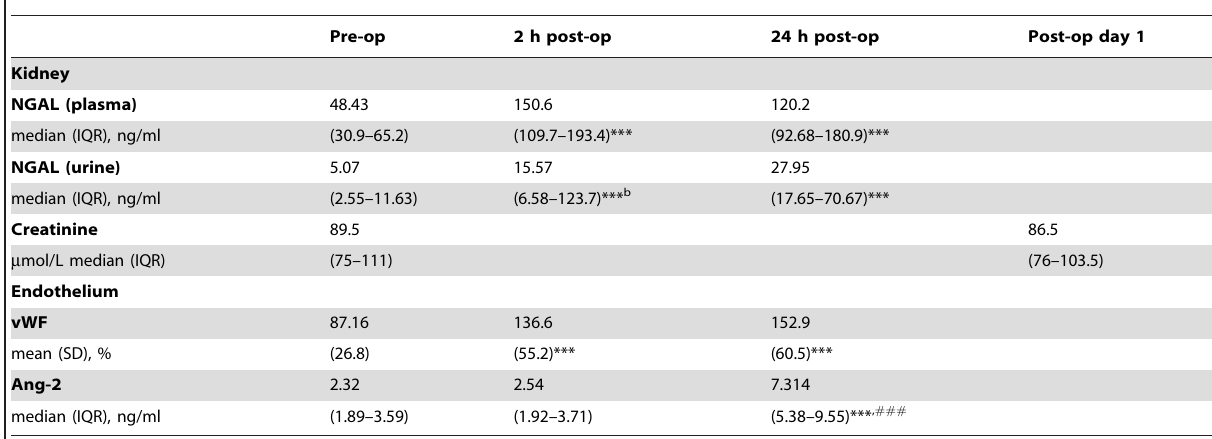
Table 3. Indices of organ dysfunction/injury a .